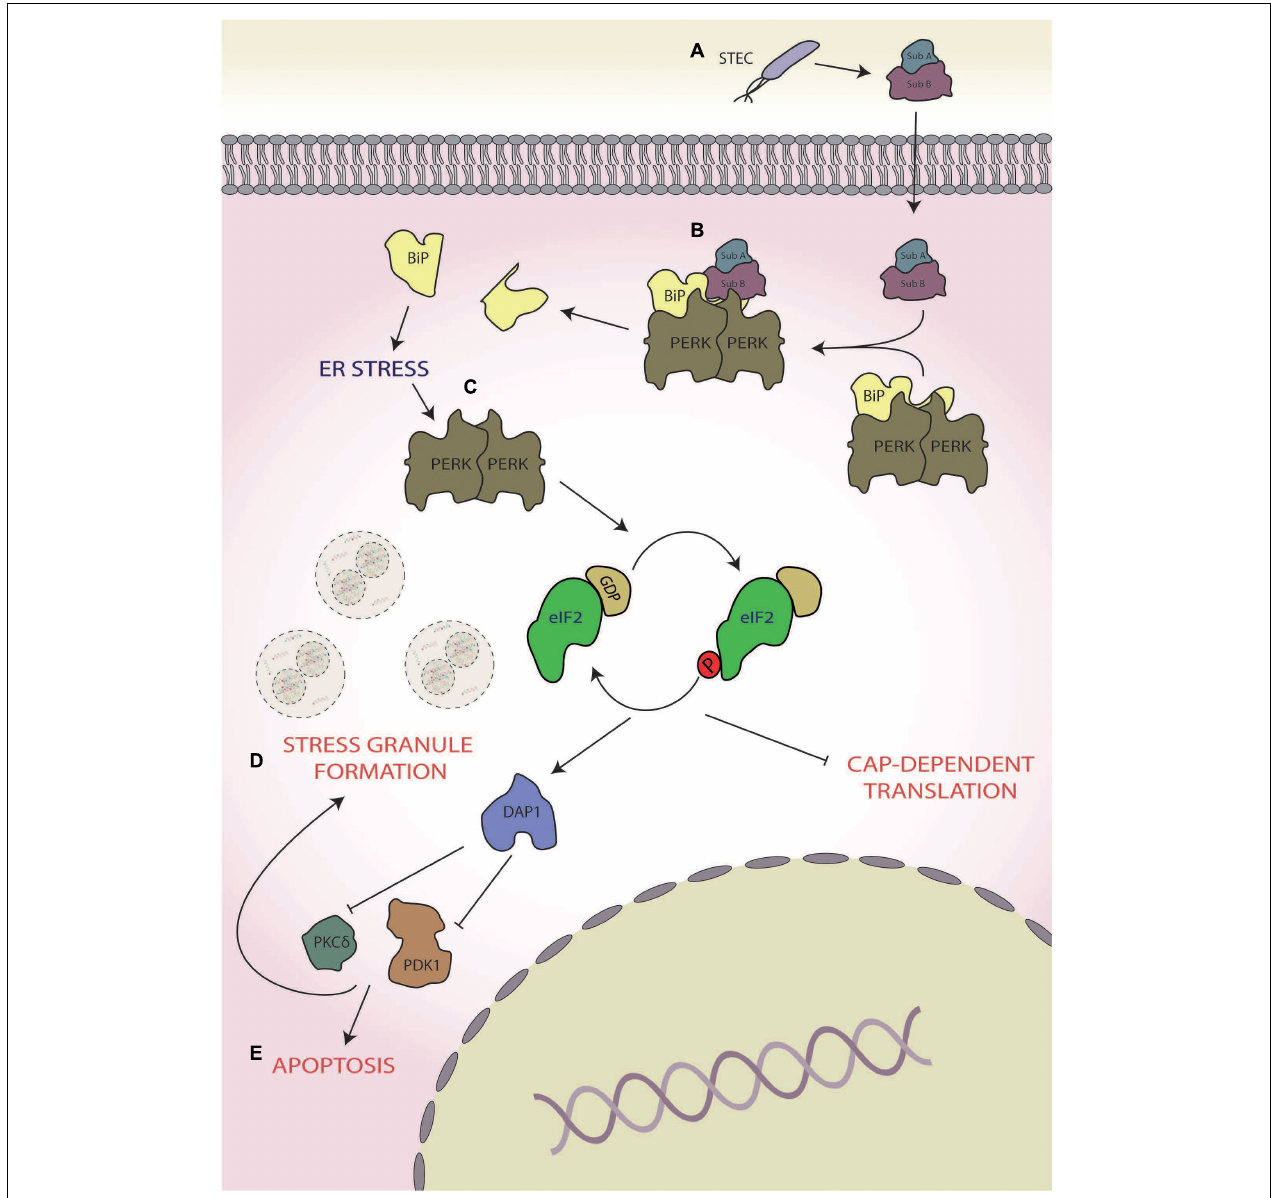
FIGURE 2 | Shiga toxin-producing Escherichia coli (STEC). (A) During infection, STEC secretes subtilase cytotoxin (subAB), (B) which cleaves protein kinase R-like endoplasmic reticulum (ER) kinases (PERKs) chaperone binding immunoglobulin protein (BiP), and (C) leading to the activation of PERK and subsequent phosphorylation of eukaryotic initiation factor 2 alpha (eIF2 α ). (D) This results in the formation of stress granules in a manner dependent on death-associated protein 1 (DAP1) activation of phosphoinositide-dependent kinase 1 (PDK1) and protein kinase C δ (PKC δ ), (E) pushing the cell towards